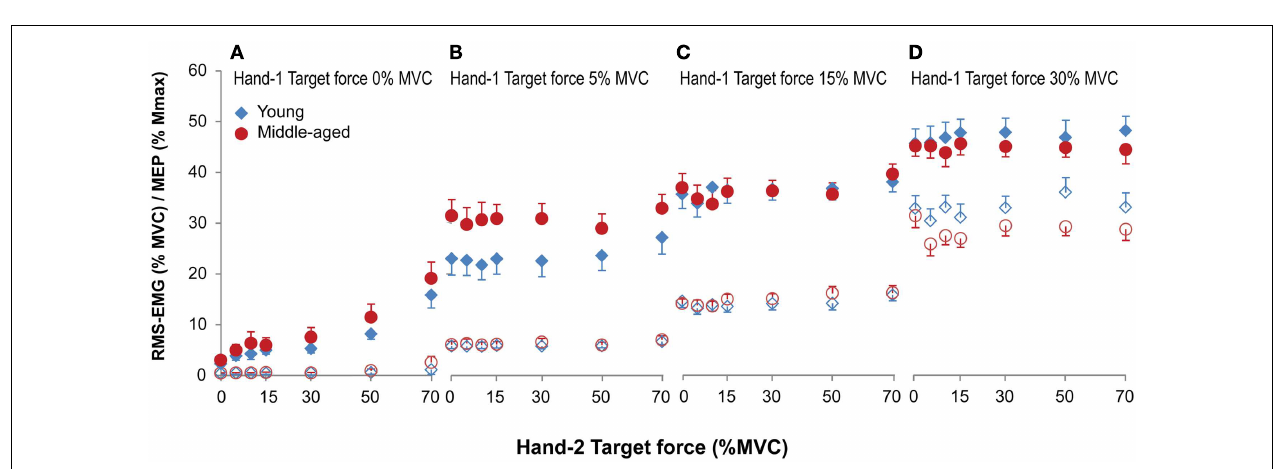
FIGURE 3 |The combination of bimanual forces produced by young (blue) and middle-aged subjects (red) .The crossing of the interrupted lines represents the target force combination for Hand-1 ( y -axis) and Hand-2 ( x -axis).The measure of bilateral performance (force difference) is calculated as the Euclidean distance between the requested force combination and the produced force combination (see Eq. 1). Significant differences in force